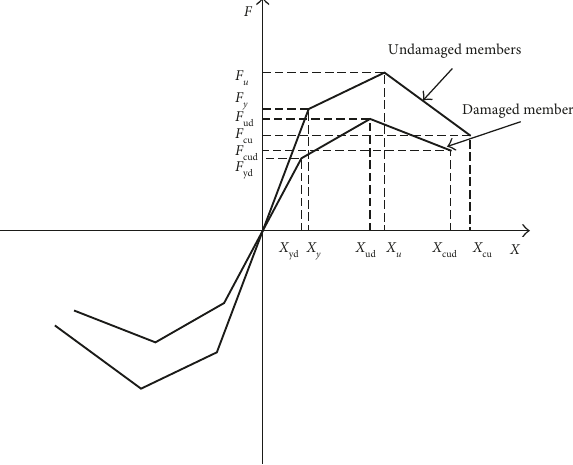
Figure 3: The force-restoring model of corroded reinforcement concrete members with flexure and